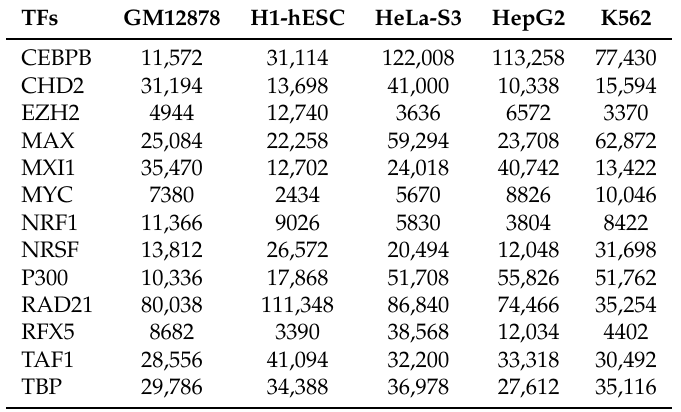
Table 6. The number of TFBSs for the additional 13 TFs in the five cell